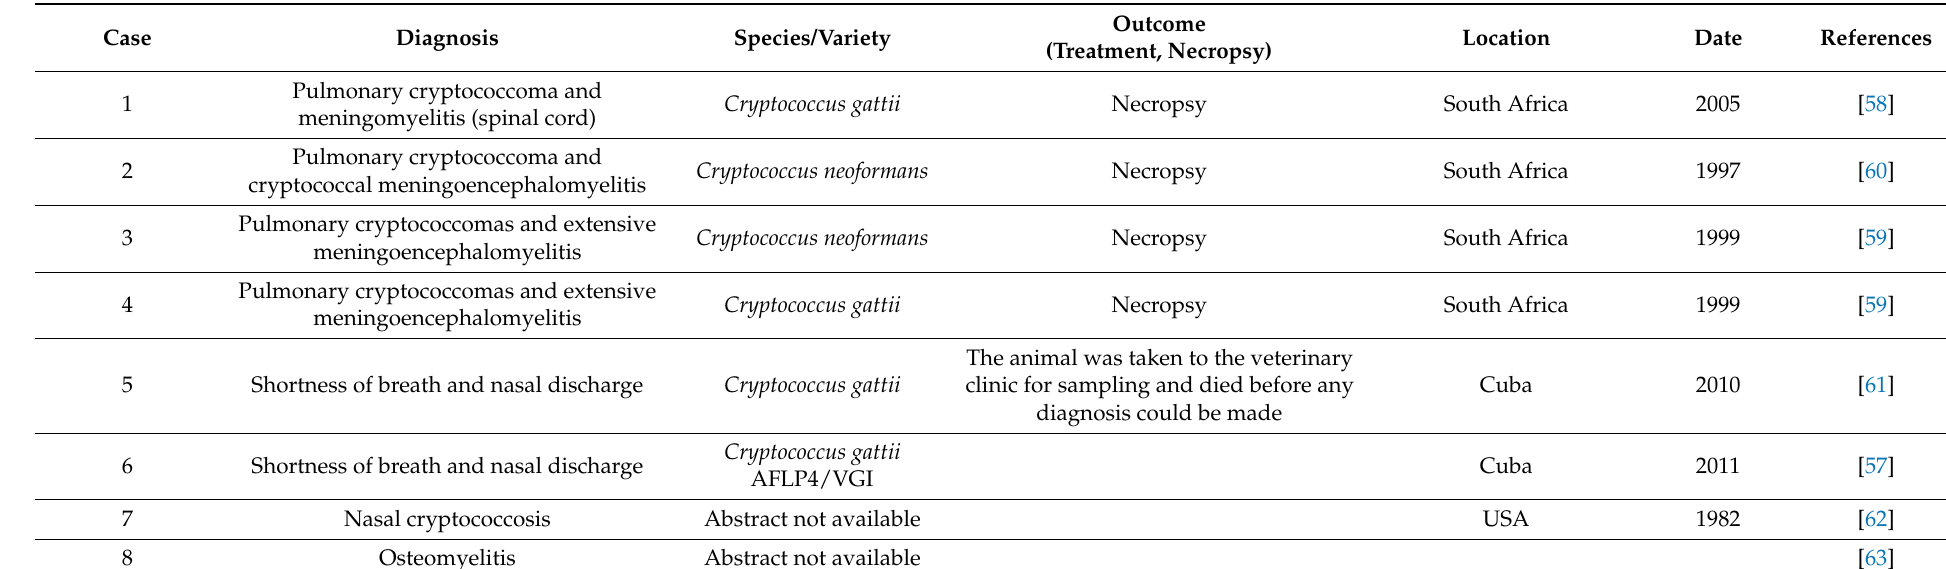
Table 1. Cryptococcosis in wild